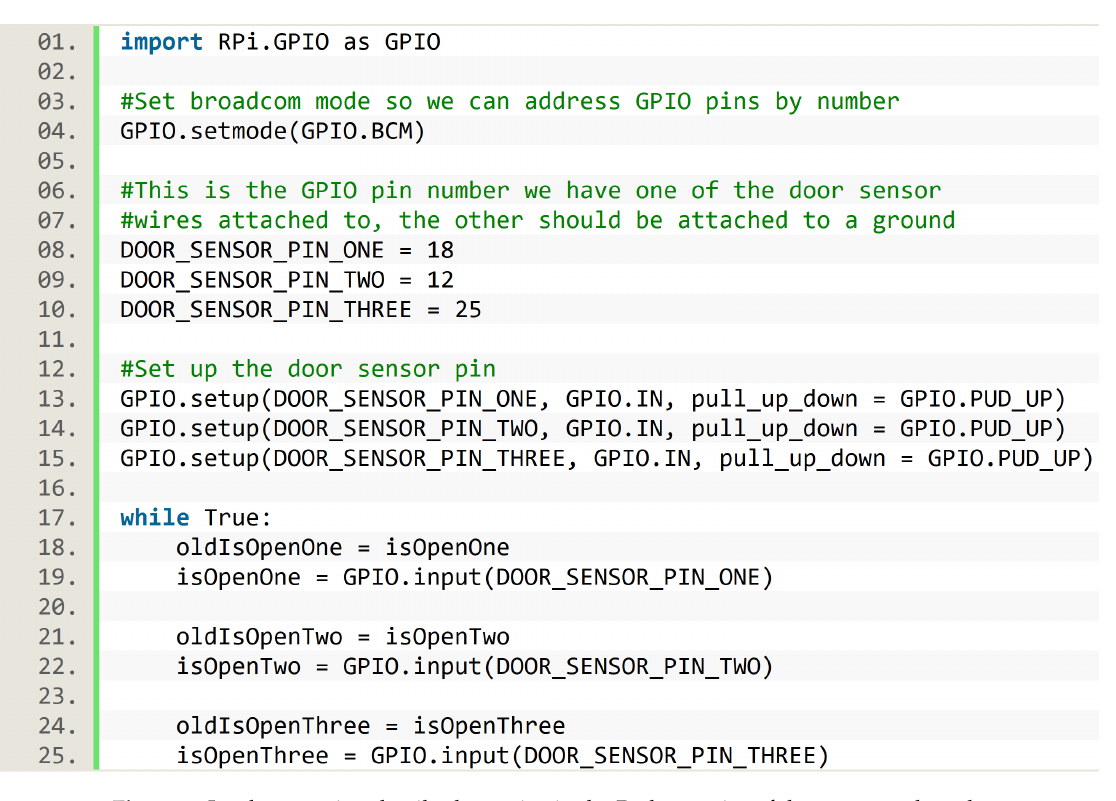
Figure 7. Implementation details about pins in the Python script of the smart